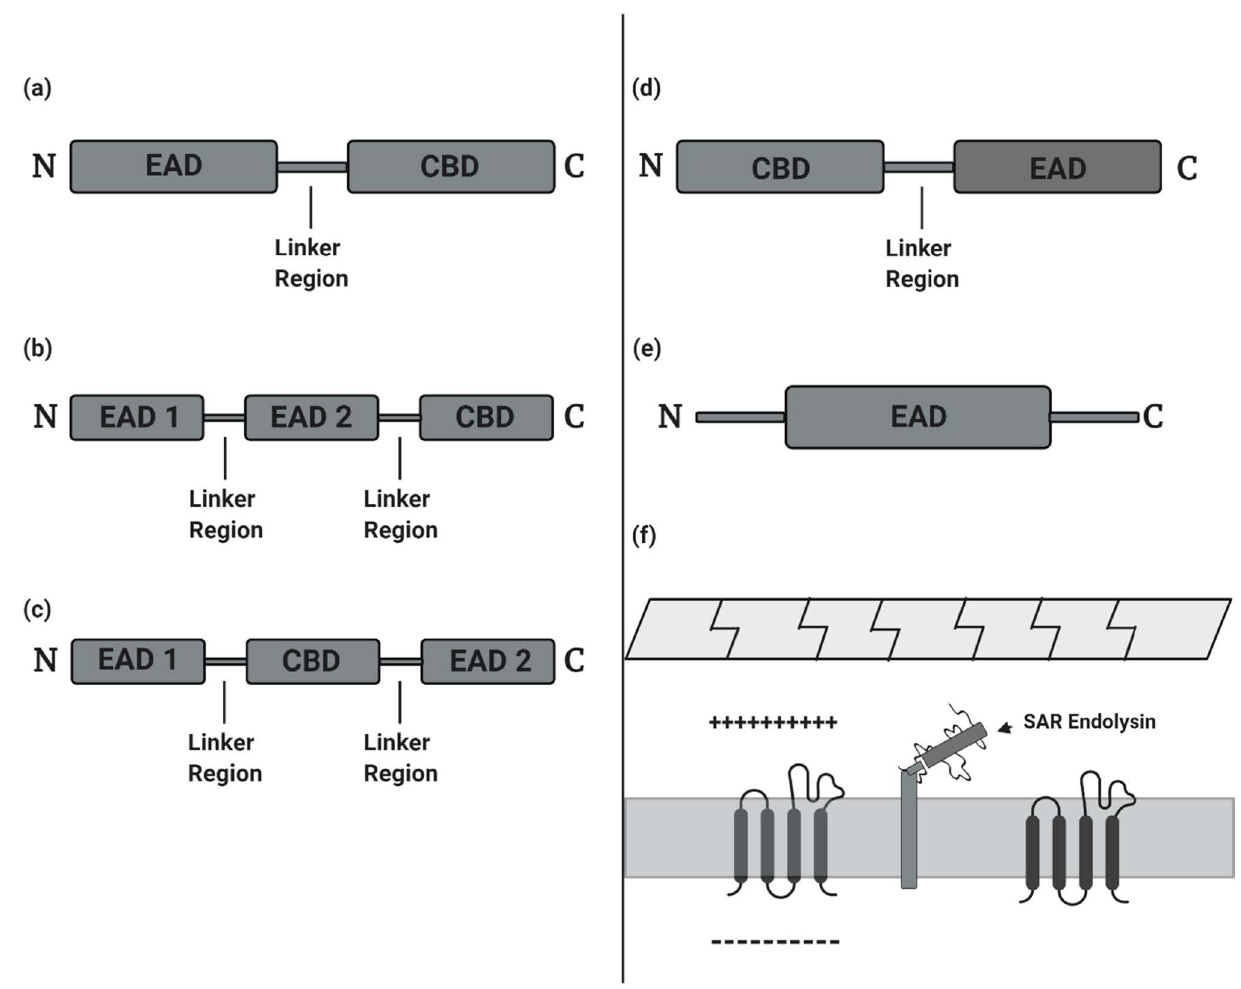
Figure 2. Modular configuration models of common phage endolysins. ( a ) Model with one N-terminal enzymatically active domain (EAD) and a C-terminal cell wall-binding domain (CBD). ( b ) Multi-domain model with two EADs and a C-terminal CBD. ( c ) Multi-domain model with a CBD located between two EADs. ( d ) Modular endolysin with a C-terminal EAD and an N-terminal CBD. ( e ) Simple globular model of an EAD with no CBD. ( f ) Model of a tethered signal-arrest-release (SAR) endolysin localized to the periplasmic membrane before release and activation of lysis function